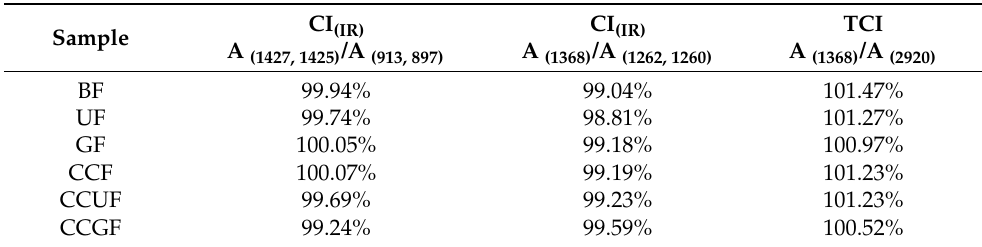
Table 4. The crystallinity index (CI (IR) ) and total crystallinity index TCI of regenerated cellulose fibers with or without additives from the FT-IR spectra.